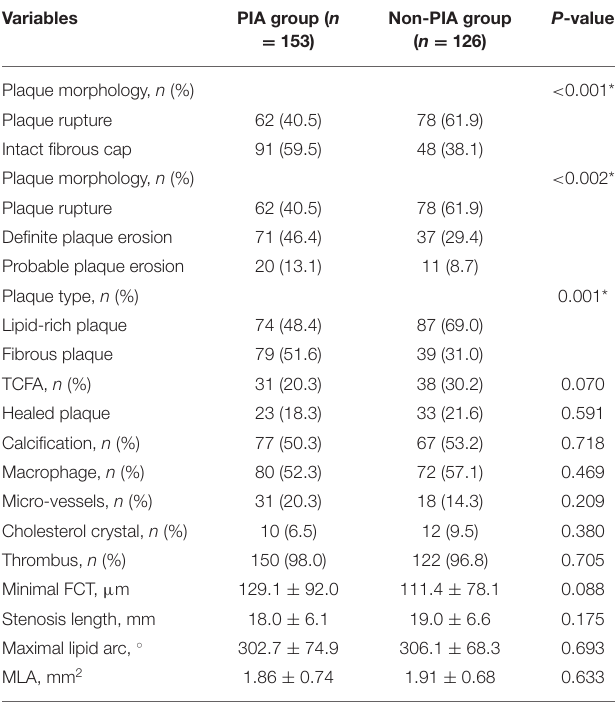
TABLE 3 | Optical coherence tomography characteristics.